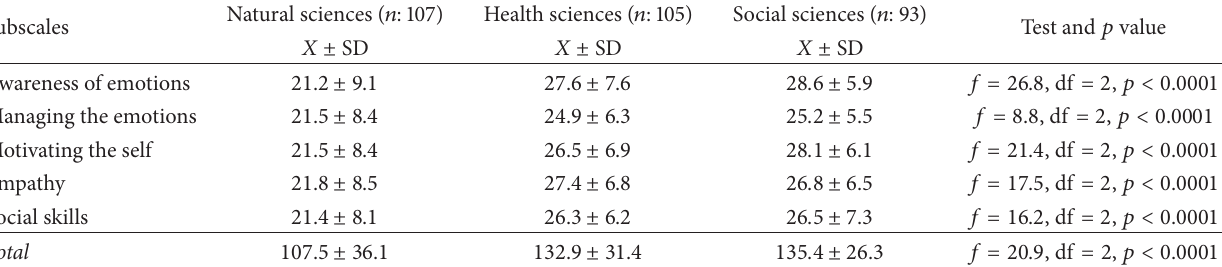
Table 3: Comparison of total scores and subscale mean scores of the emotional intelligence scale according to departments. Natural sciences ( 𝑛 : 107) Health sciences ( 𝑛 : 105) Social sciences ( 𝑛 : 93) Subscales 𝑋 ± SD 𝑋 ± SD Awareness of emotions 21.2 ± 9.1 𝑓 = 26.8 , df = 2 , 𝑝 < 0.0001 Managing the emotions 21.5 ± 8.4 𝑓 = 8.8 , df = 2 , 𝑝 < 0.0001 Motivating the self 21.5 ± 8.4 Empathy Social skills 𝑓 = 16.2 , df = 2 , 𝑝 < 0.0001 Total 107.5 ± 36.1 𝑓 = 20.9 , df = 2 , 𝑝 <